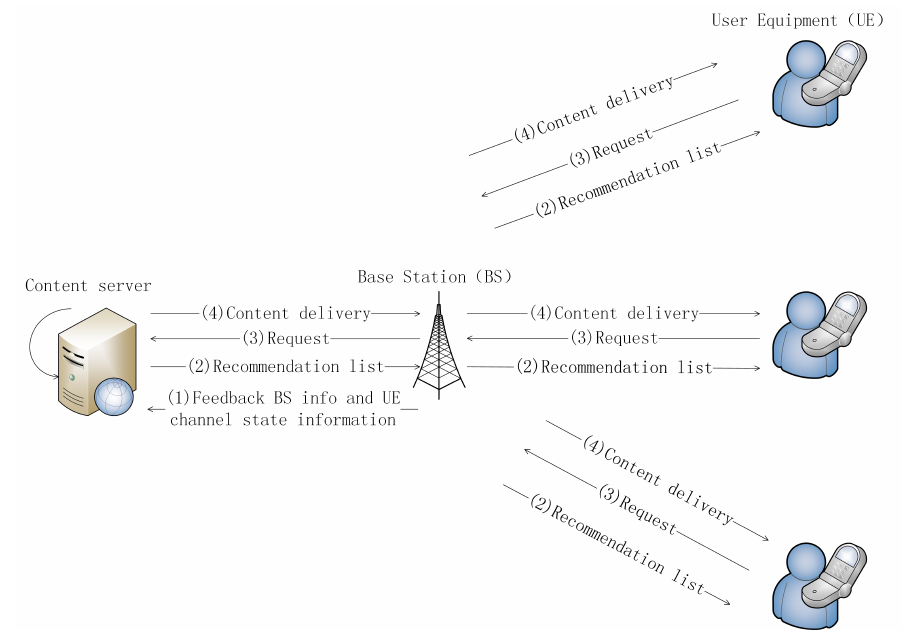
Figure 1. Interactive content retrieval protocol for personalized multi-user content